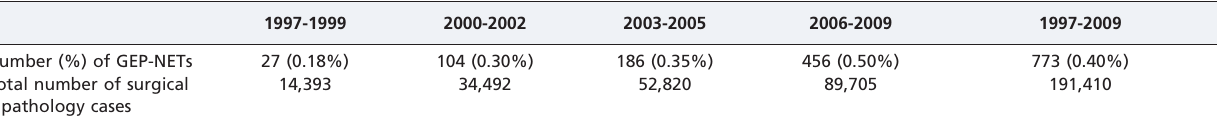
Table 2 - The distribution of the number and percentage of GEP-NET cases from 1997 to 2009 per three-year period